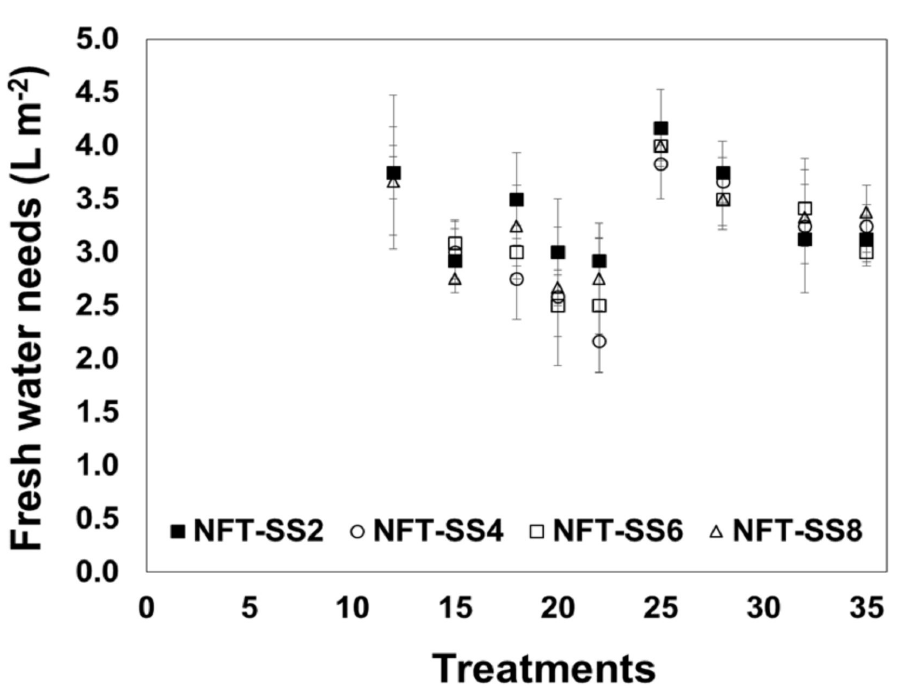
Figure 2. Total fresh water needs (L m − 2 ) of the basil crop grown in the NFT system irrigated by means of the NFT-SS treatments during the second period.